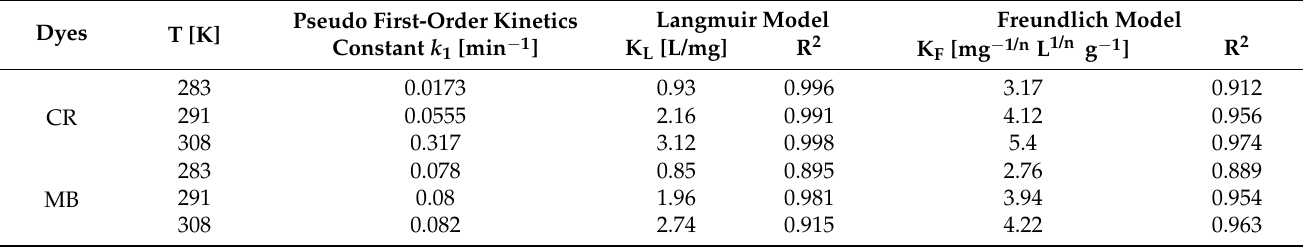
values were between 0 and 1, indicating favorable adsorption.